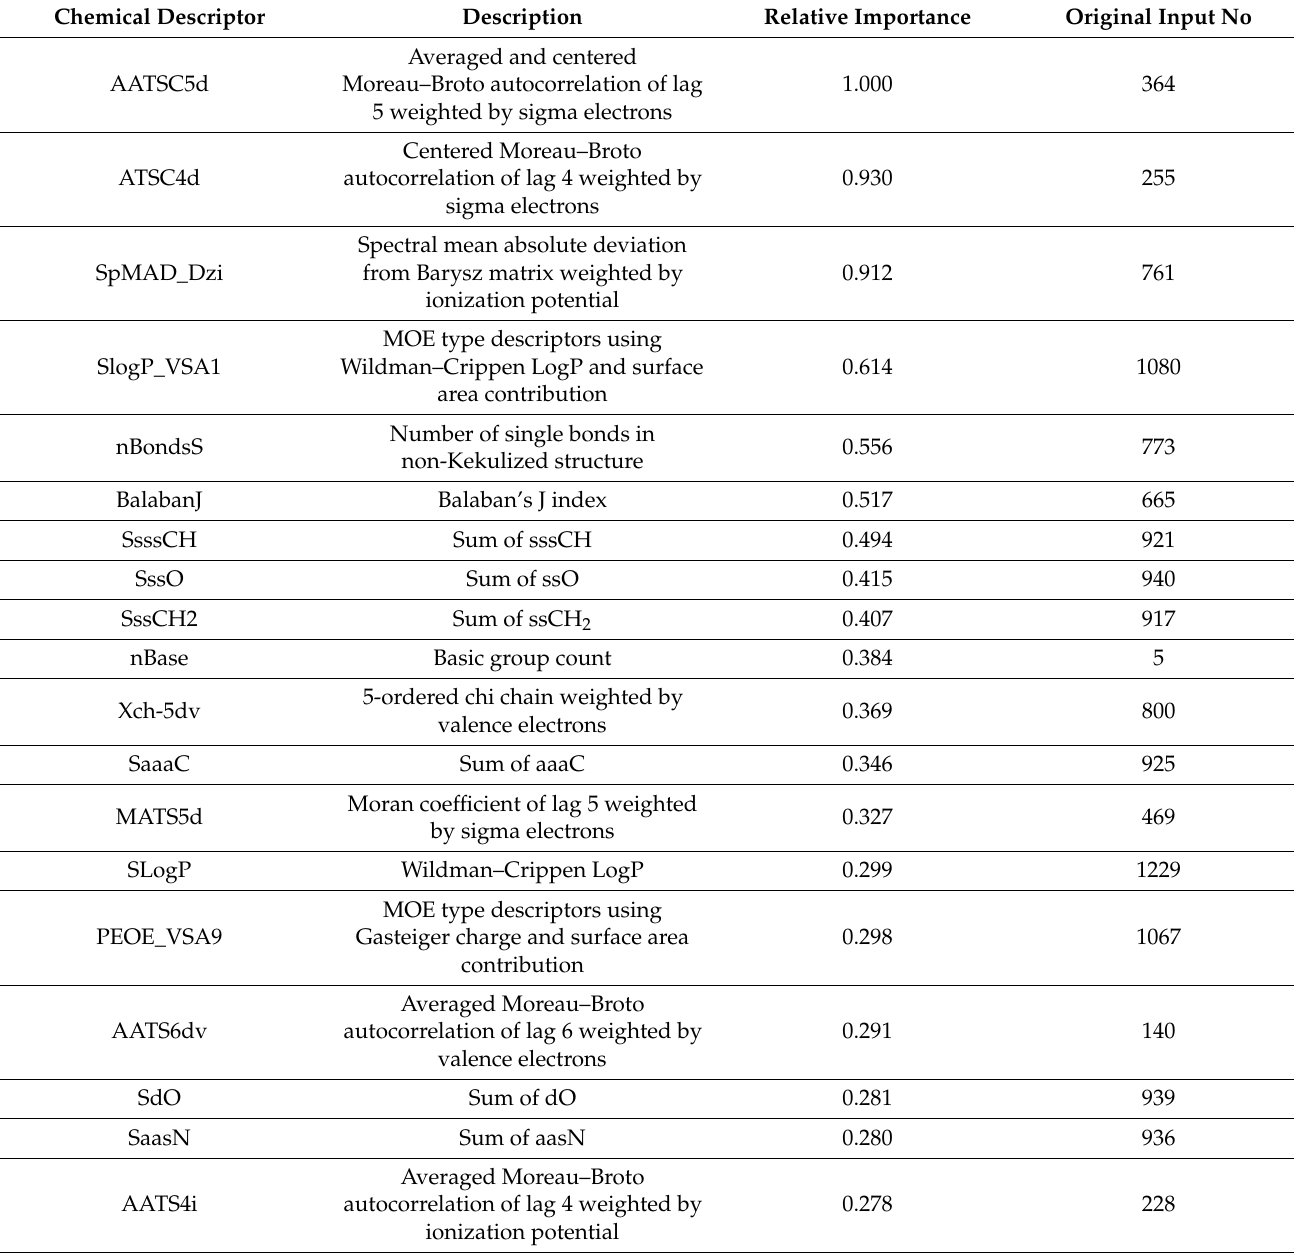
Table 3. Top 20 variables from 216 selected during feature